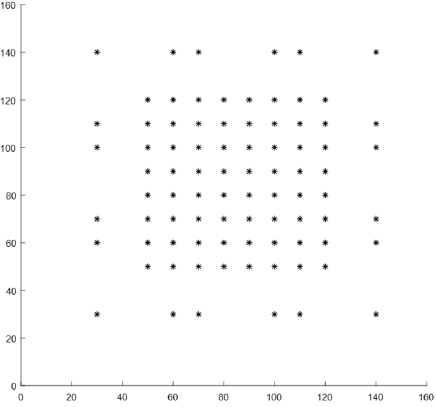
Figure 4. Geometric points marked in the geometric model.